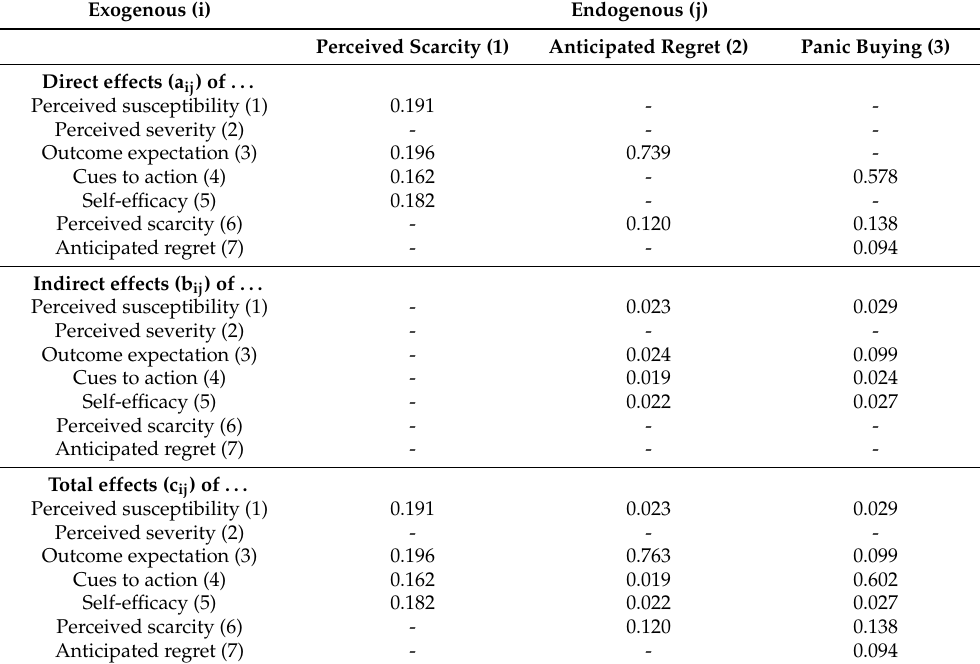
Table 6. Direct, indirect, and total